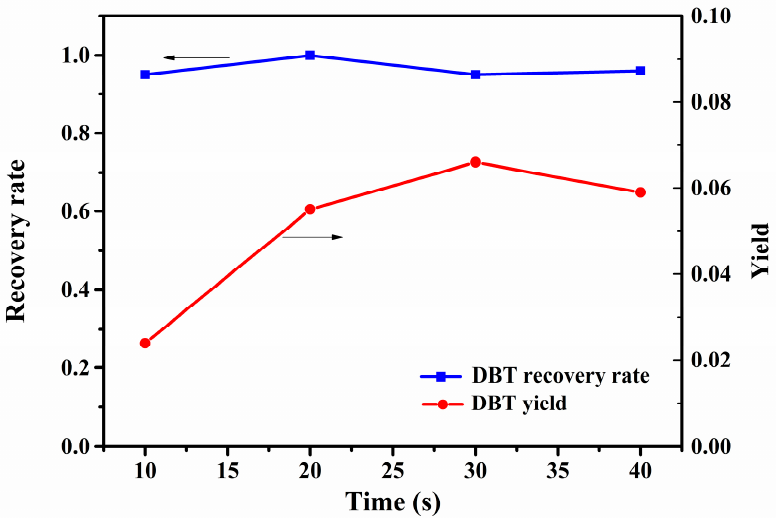
Figure 4. The recovery rate and yield of DBT on alcohol flame.